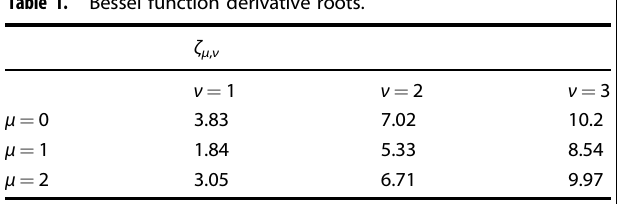
Fig. 2 Bessel mode pro fi les. Bessel modes with free boundary conditions J μ ζ μ ; ν r number ν = 1 – 3. Table 1. Bessel function derivative